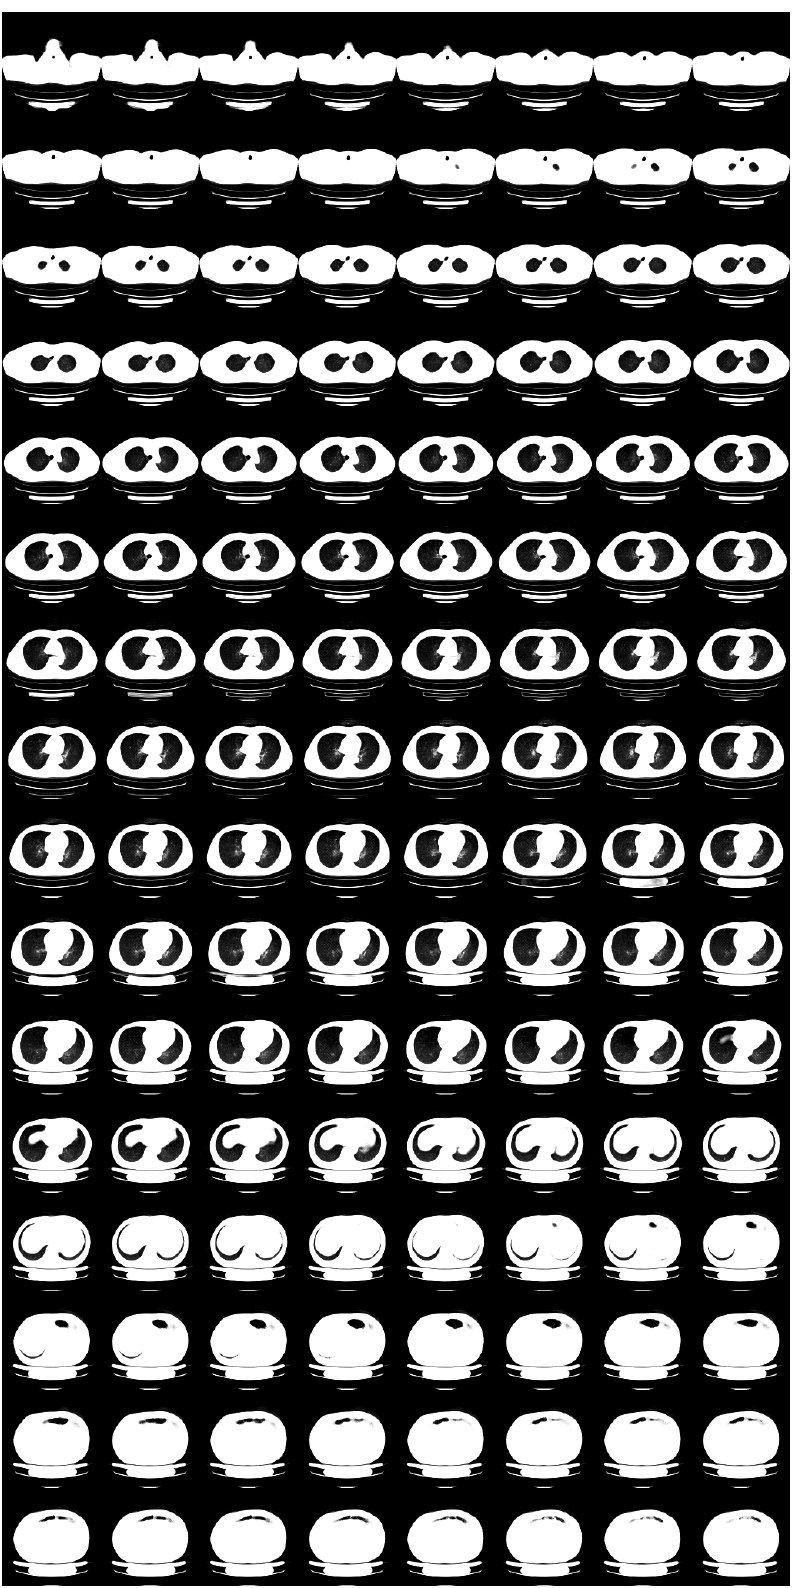
Figure 4. Reconstructed 3D CT image with X2CT-FLOW from Figure 3a,b ( σ 2 = 0, N = 2), in pul- monary window